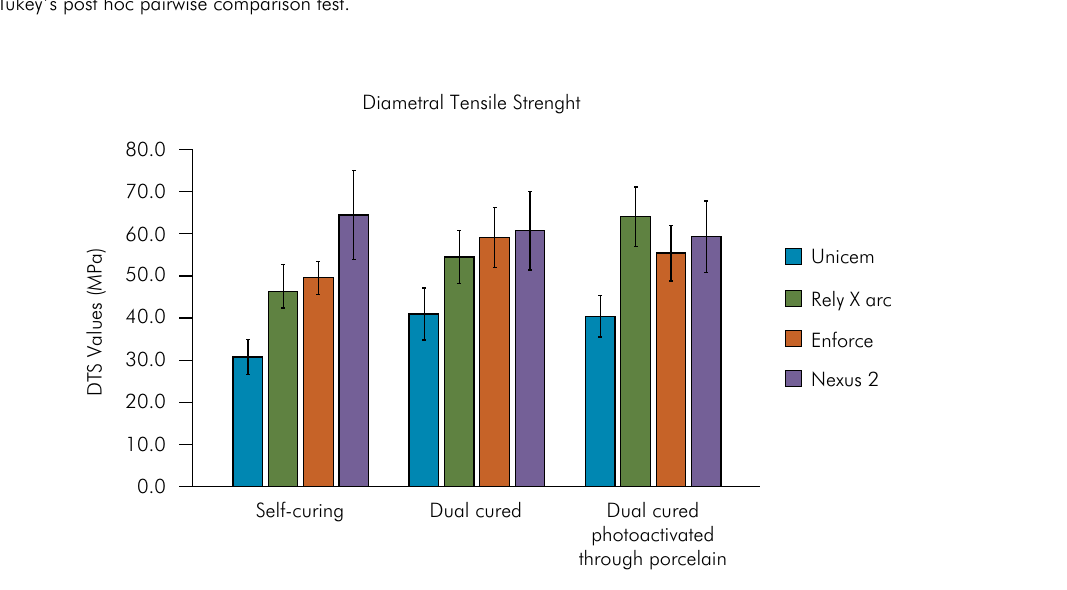
Figure 6. Mean diametral tensile strength.